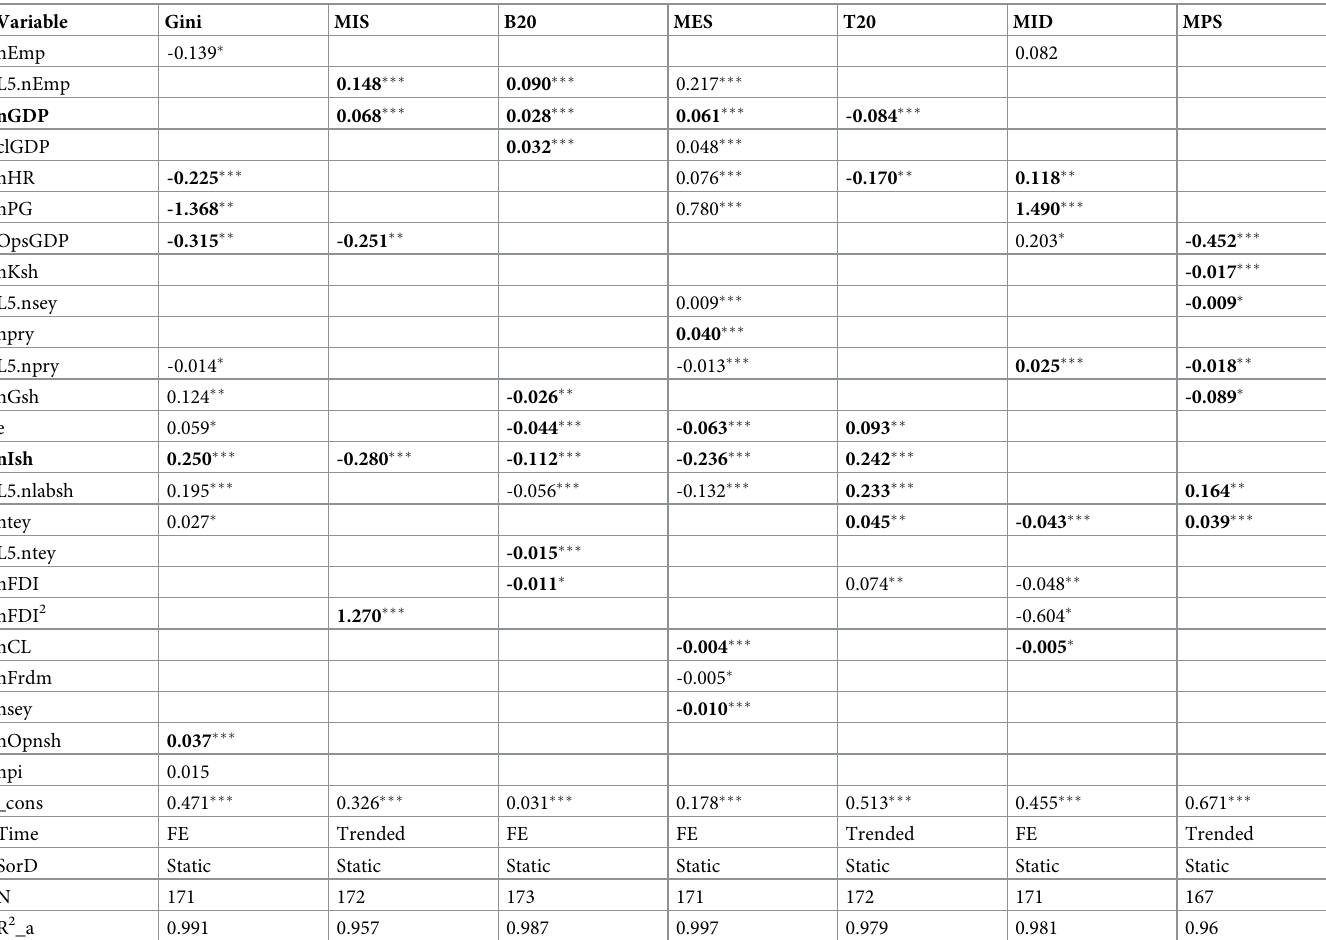
Note: All estimates in the table are robust in at least three of the four estimations and the other estimates are not listed in the table. Highlighted estimates are robust in the four regressions. Shaded values denote inconsistent estimates of Gsh on Gini, MPS and B20. Estimates of piGDP and nlabsh are not significant for all (or not more than 1) 7 inequality statistics and not listed in the